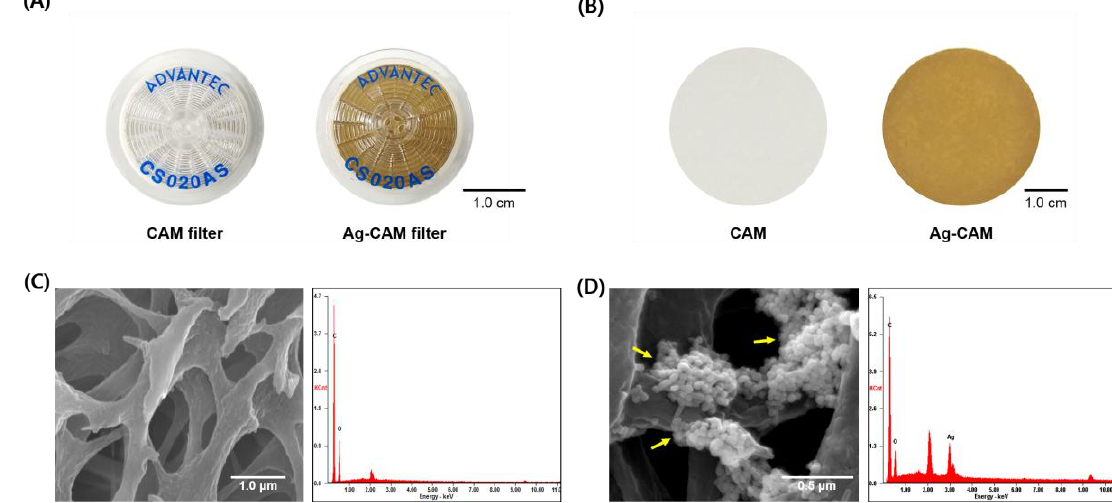
Figure 2. Characterization of Ag-CAM: ( A ) Photographic images of the CAM filter (left) and Ag-CAM (right) prepared using a syringe filter; ( B ) photographic images of the CAM (left) and Ag-CAM (right) prepared using a vacuum filter holder; ( C ) SEM–EDX analysis of the CAM (40,000×); and ( D ) Ag-CAM (100,000×). Yellow arrows in the images indicate AgNPs on cellulose fibers.